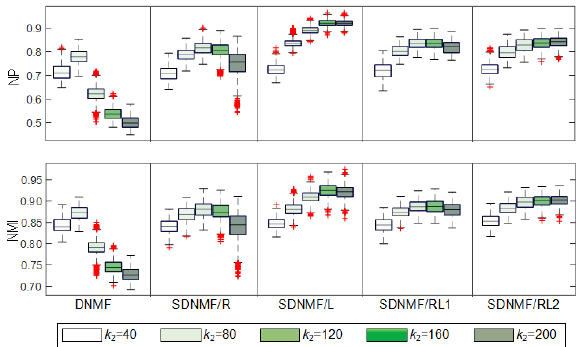
Fig. 5 k 2 selection of our proposed linear deep models on PIE-pose 27.0 dataset. Each linear model was tested under five conditions: layer size = [600, 40], [600, 80], [600, 120], [600, 160], and [600, 200].